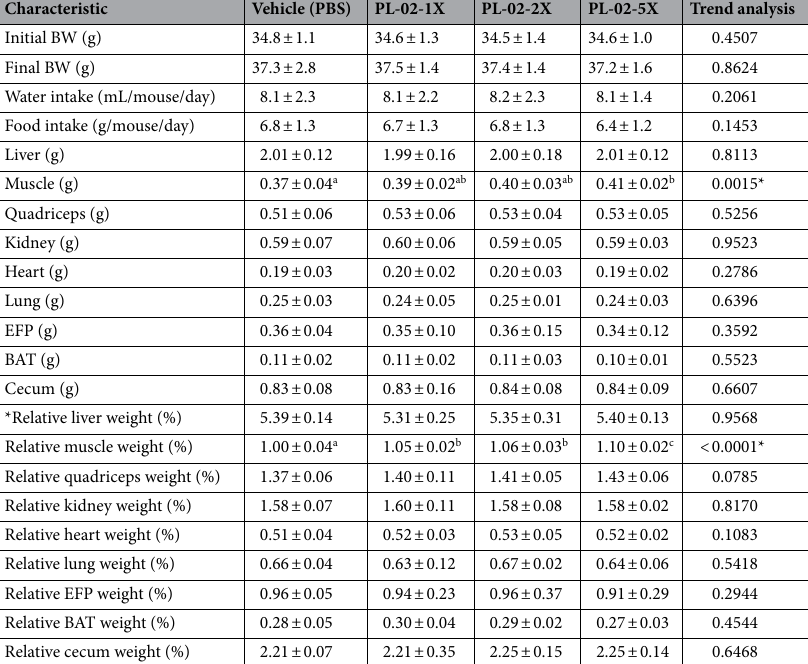
Table 1. Effect of PL-02 supplementation on various parameters. Data are expressed as mean ± SD ( n = 10 mice per group). EFP epididymal fat pad, BAT brown adipose tissue. *Relative to body weight.